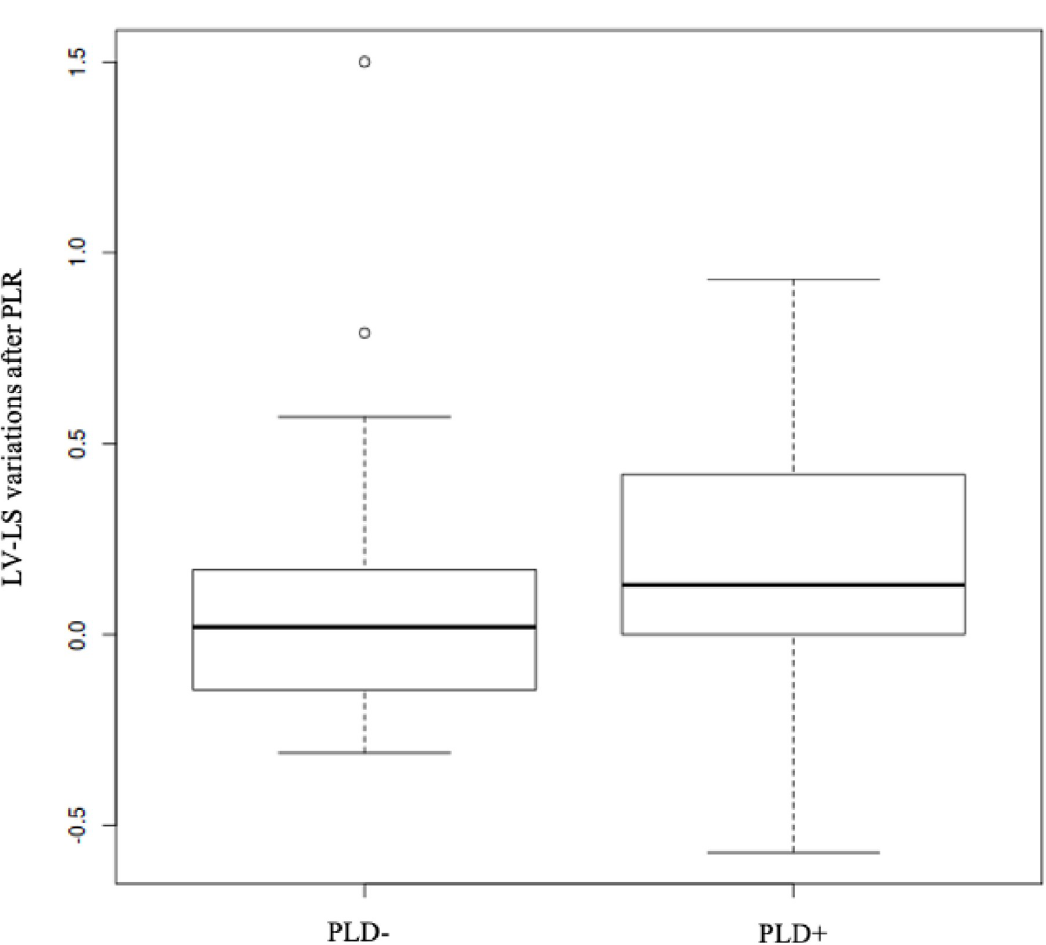
Fig 3. Variations of mean LV-LS after a passive leg raising. + 11% ( ± 38%) in the PLD- group versus + 19% ( ± 31%) in the PLD+, p = 0.08 (Kruskal-Wallis test). Dark line represents the median for each